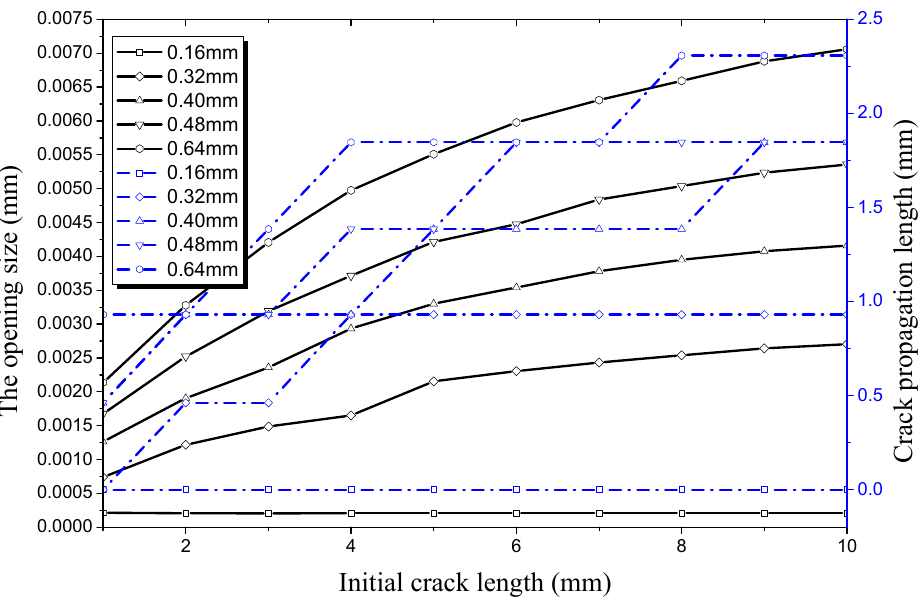
Figure 16. Relationship between longitudinal crack propagation length and initial crack length on the outer surface, and relationship between longitudinal opening size and initial crack length on the outer surface, both under an internal pressure of 35 MPa.